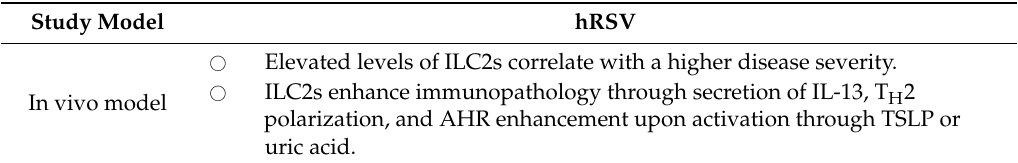
Table 6. Role of ILCs in the pathology caused by